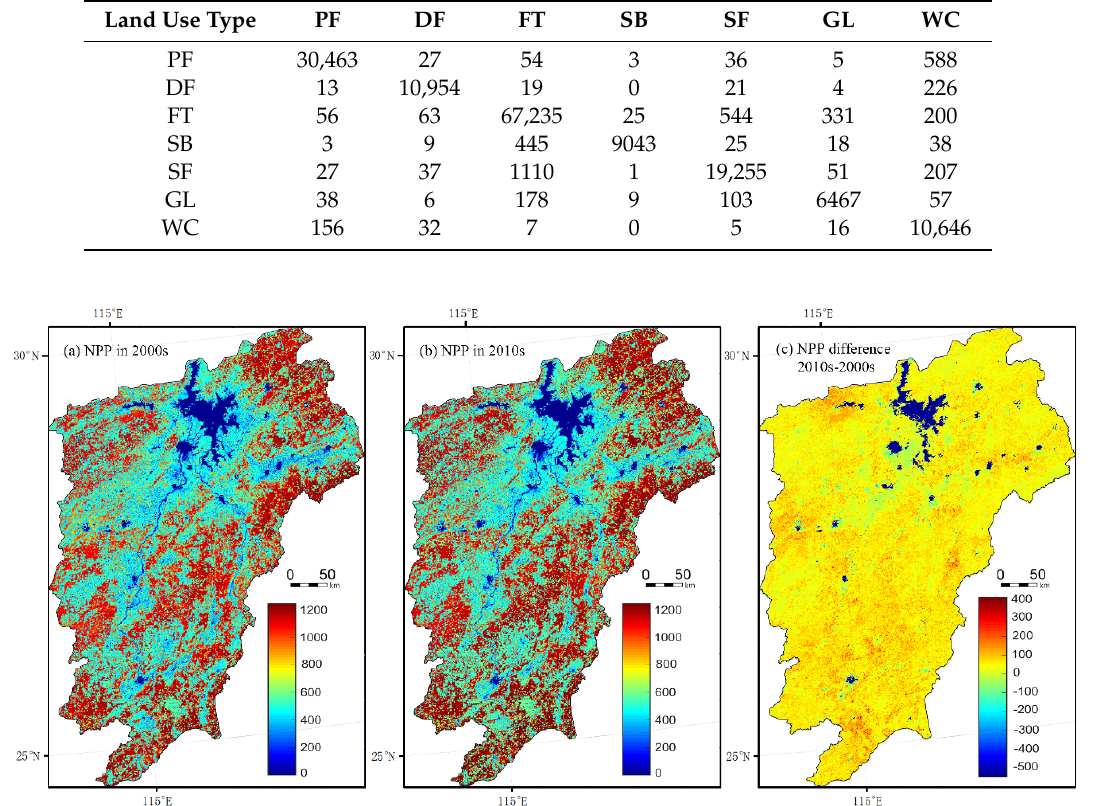
Figure 5. Spatial distribution of net primary productivity (NPP) in ( a ) 2000s (2000–2009) and ( b ) in 2010s (2010–2017); ( c ) shows the change of NPP between 2000s and 2010s.